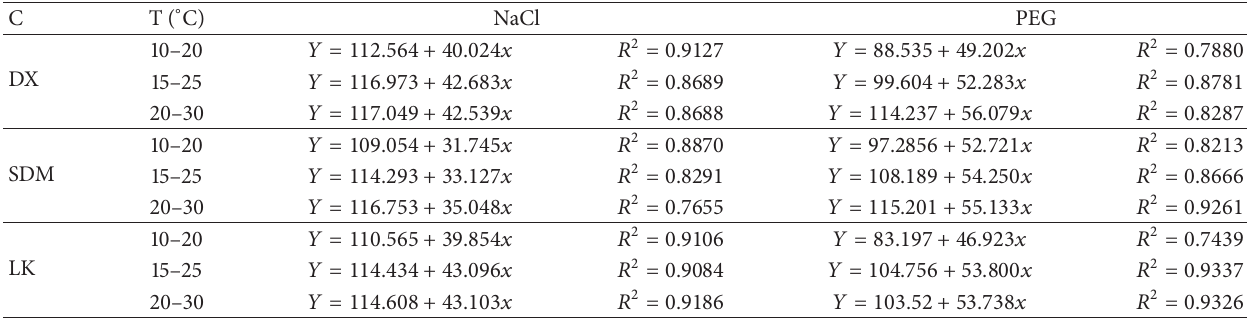
Table 2: The linear regression equations of rate of germination and the water potential under different temperature regimes. All regressions are significant at 𝑃 < 0.05